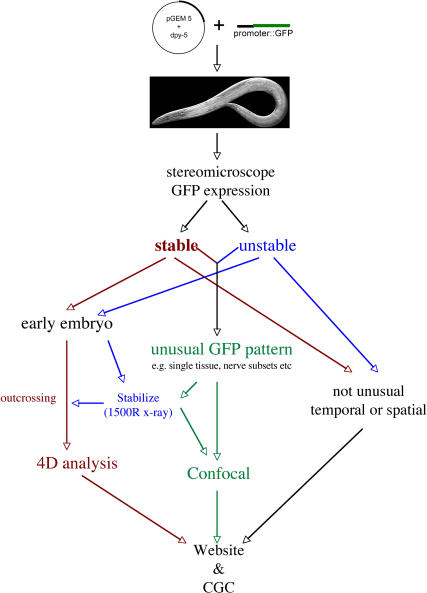
Analysis Pipeline for GFP Expressing StrainsStrains with nonubiquitous embryonic expression prior to 2-fold stage were stabilized for 4-D analysis, and all postembryonic strains were briefly assessed for their expression pattern complexity and then assigned to either the confocal microscope or the stereomicroscope for detailed observations. Once the expression analysis was complete, the data were sent to the public domain, and the strains were sent to the CGC (Caenorhabditis Genetics Center).